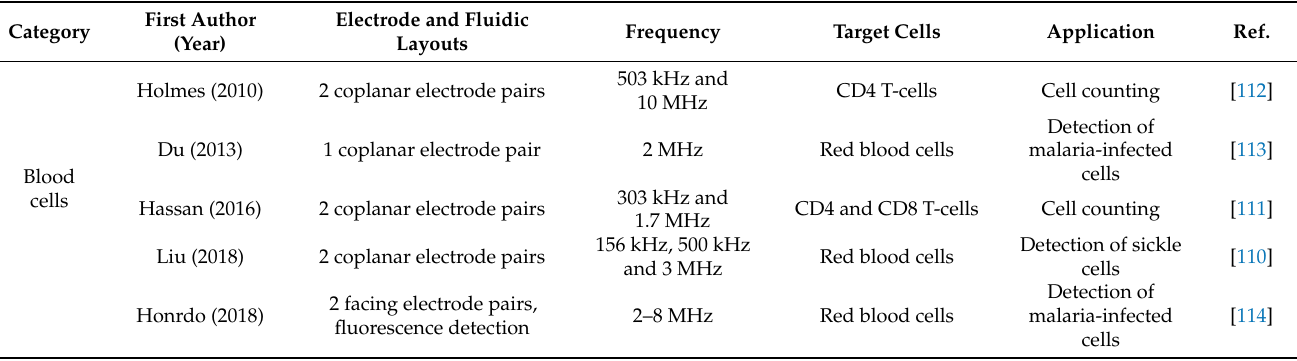
Table 1. Applications of IFC for single-cell